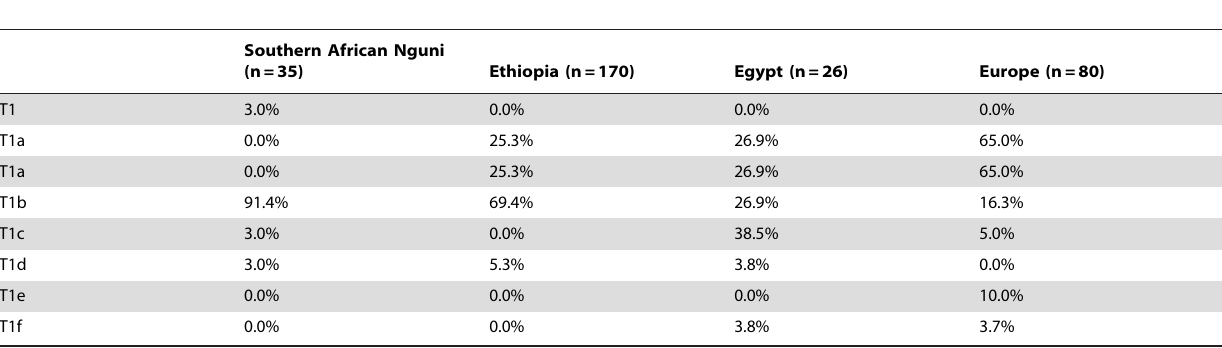
Table 1. The frequencies of the T1 subhaplogroups found by Bonfiglio et al [13] among Egyptian, Ethiopian and European T1 cattle, tabled with the frequencies among the Southern African Nguni cattle in our dataset.